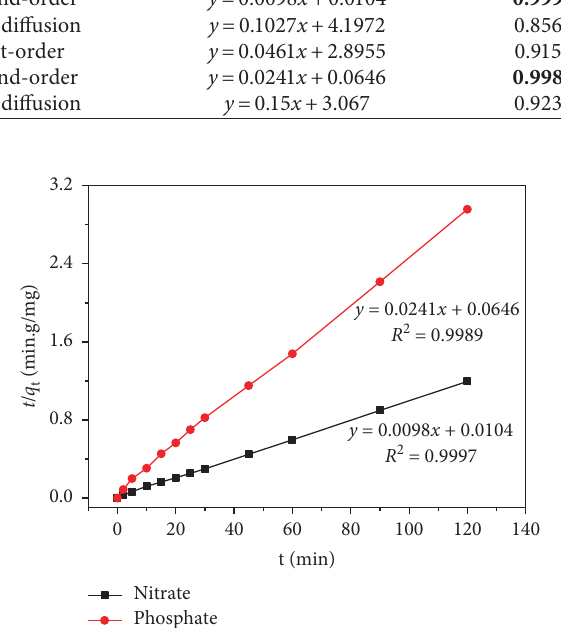
Figure 7: Pseudo-second-order kinetic plot of nitrate and phosphate adsorption onto ferric oxide-amine material.